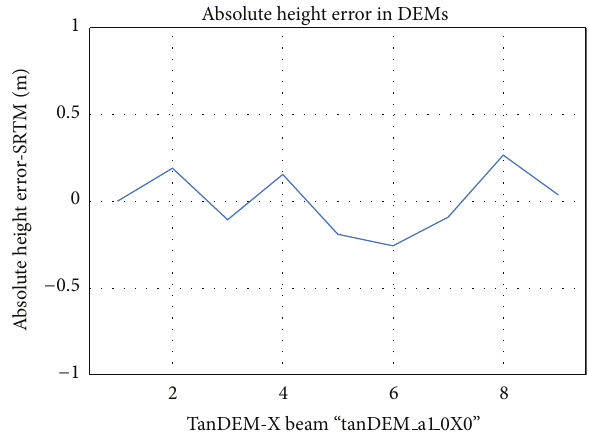
Figure 7: Beam to beam dependency of the phase